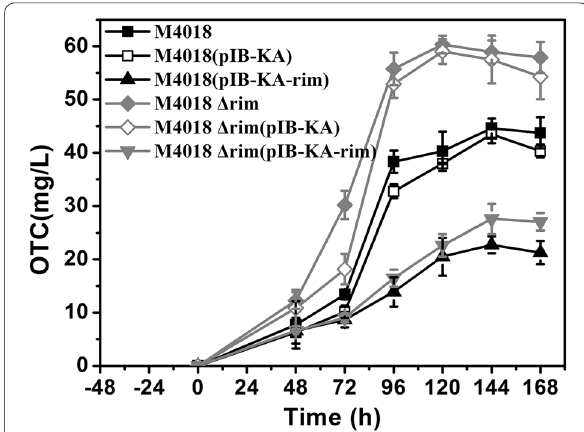
Fig. 5 OTC production by M4018 and the engineered strains cultivated on MM medium supplemented with 50 mM Gly. Vertical error bars correspond to the standard error of the mean of three replicated cultures. Black square: parental strain M4018; white square: parental strain M4018 with a control plasmid pIB-KA; black up-pointing triangle: rimA1A2 -overexpressed mutant M4018 (pIB-KA-rim); black diamond: rimA1 -disrupted mutant M4018 Δrim; white diamond: M4018 Δrim with a control plasmid pIB-KA; black down-pointing triangle: rimA1A2 -complemented mutant M4018 Δrim